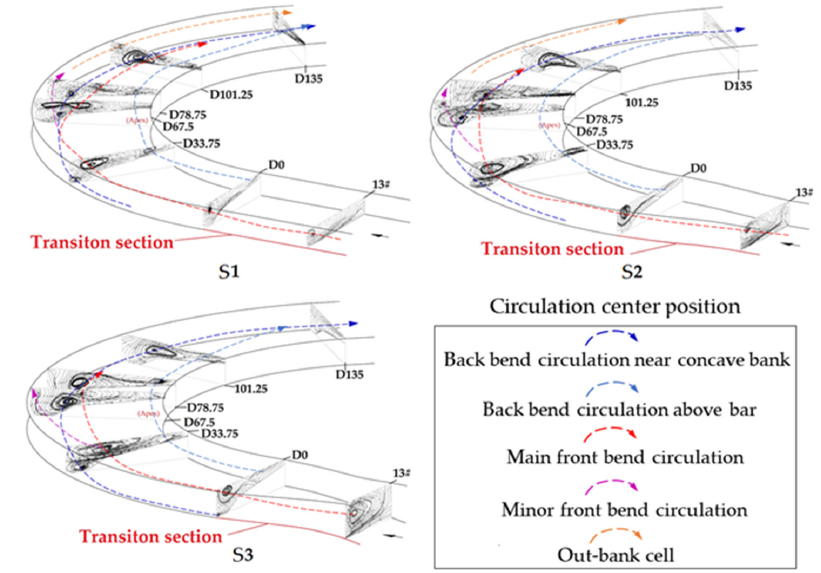
Figure 5. Circulation structure distribution change of typical cross-sections along the back bend at Q3 under different scenarios. The dark blue, blue, red, purple and orange dotted lines denote different circulation centre positions along the continuous bend, respectively.